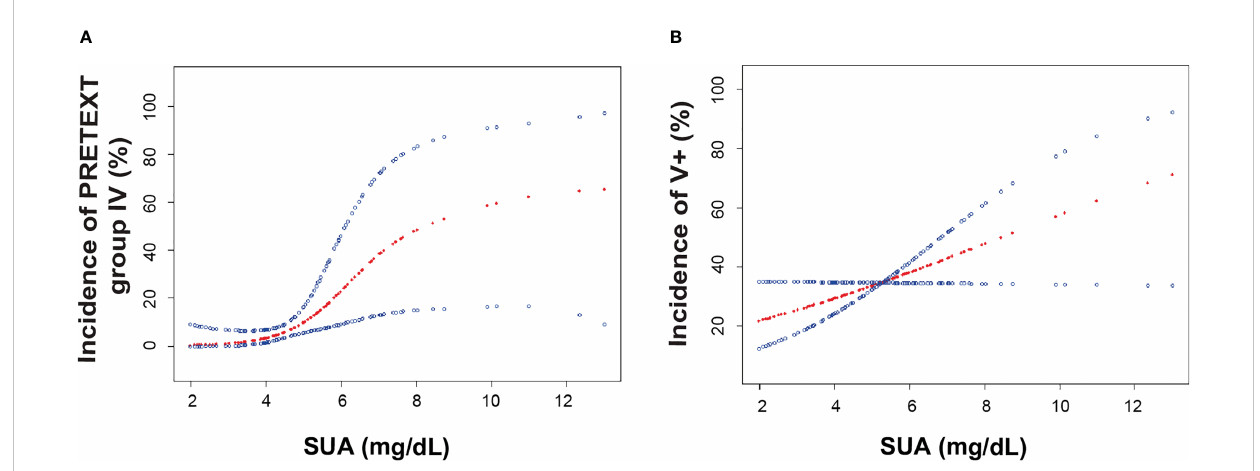
FIGURE 2 The association of serum uric acid and the incidence of PRETEXT staging IV and vascular involvement. (A) . Smoothing spline plots of SUA and the incidence of PRETEXT staging IV in HB patients, adjusted for age, sex, BMI, Scr. (B) . Smoothing spline plots of SUA and the incidence of PRETEXT annotation V, adjusted for age, sex, BMI, Scr. Red lines represent the spline plots of SUA concentration (mg/dL) and blue lines represent the 95% con fi dence intervals of the spline plots. Abbreviations: BMI, body mass index; SCr, serum creatinine; SUA, serum uric acid; AFP, a -fetoprotein; PRETEXT, pretreatment extent of